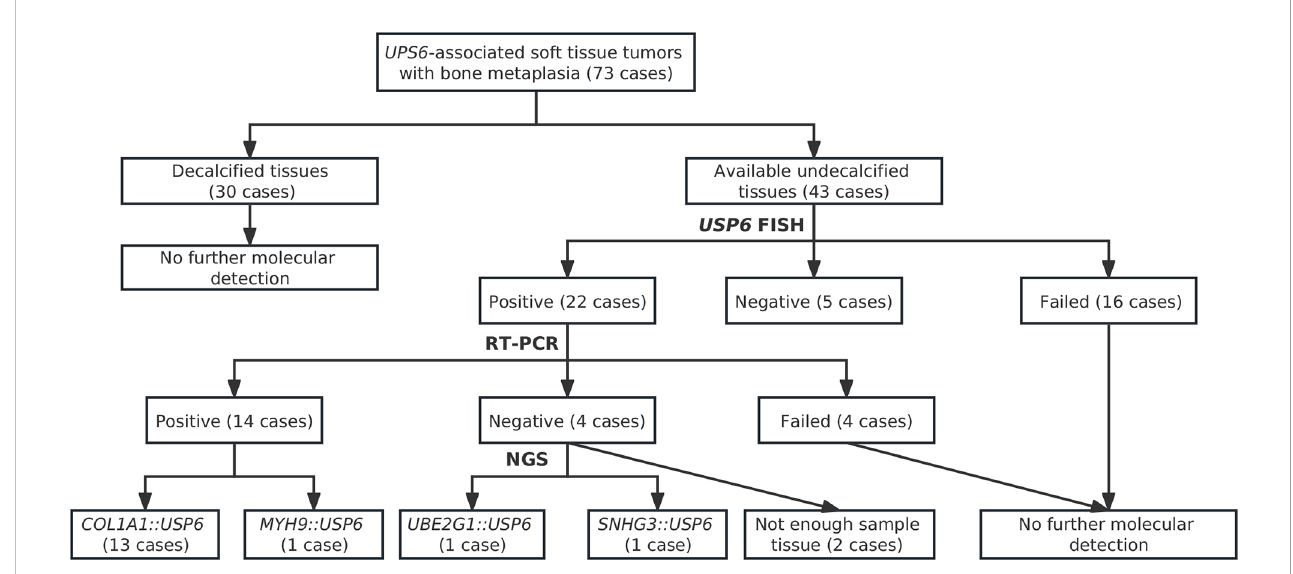
FIGURE 6 Summary of process and results for genetic testing of USP6 -associated